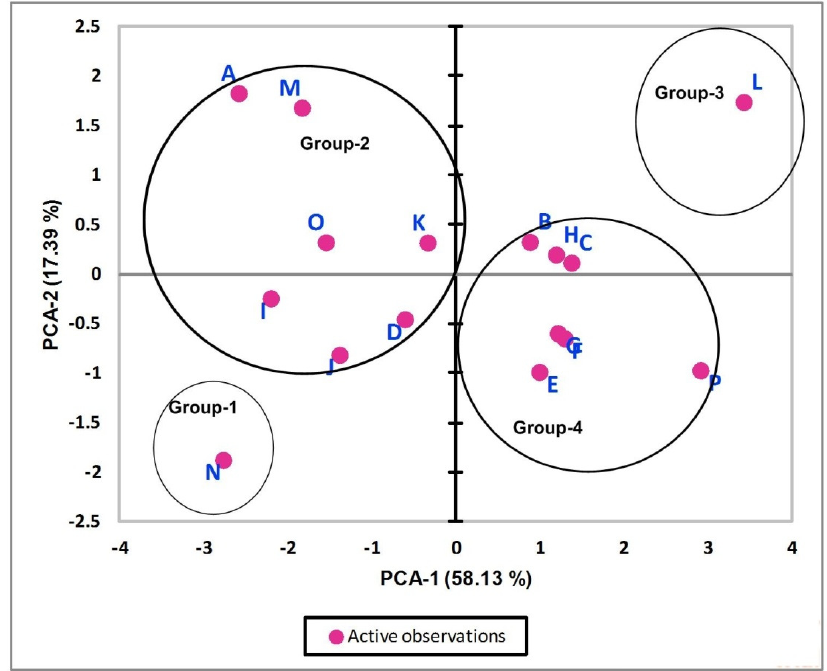
Figure 4. Loadings of magnetic characteristics of soft magnetic materials on PCA-1 and PCA-2 .